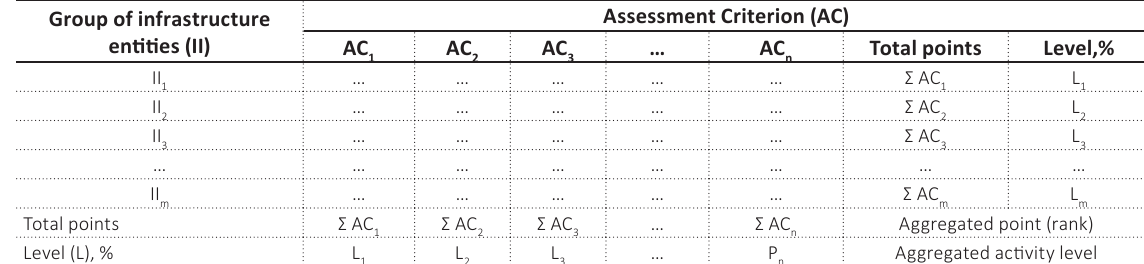
Source: Developed by the